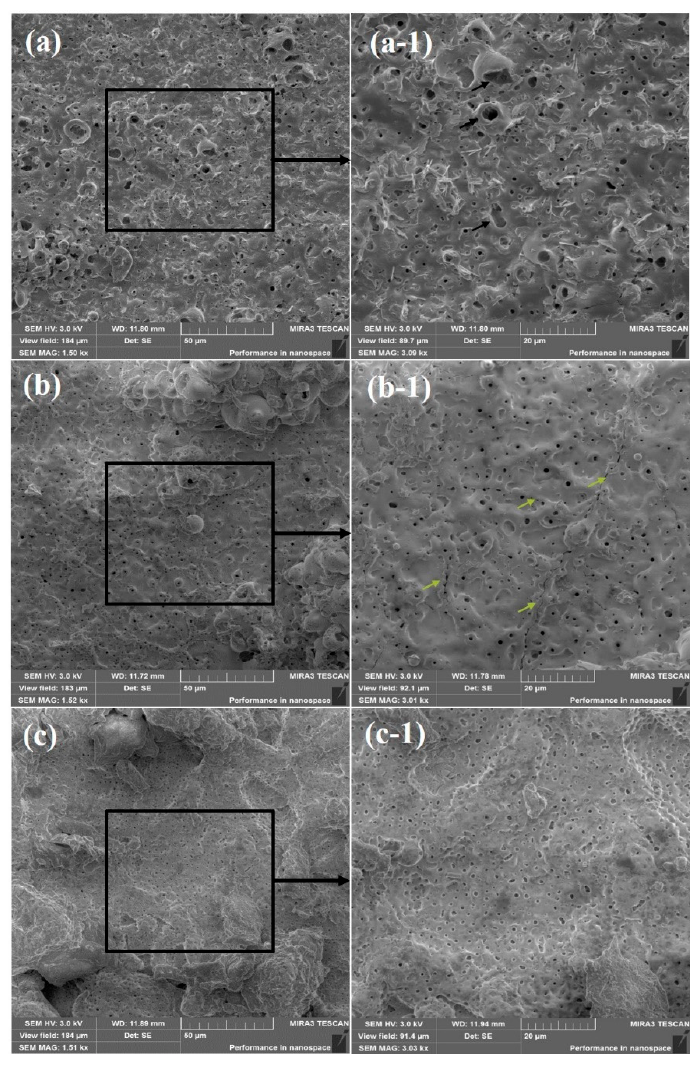
Figure 3. PEO coating surface morphology of various electrolytes ×1500: ( a ) H; ( b ) P; ( c ) S, and ×3000: ( a-1 ) H; ( b-1 ) P; ( c-1 ) S.